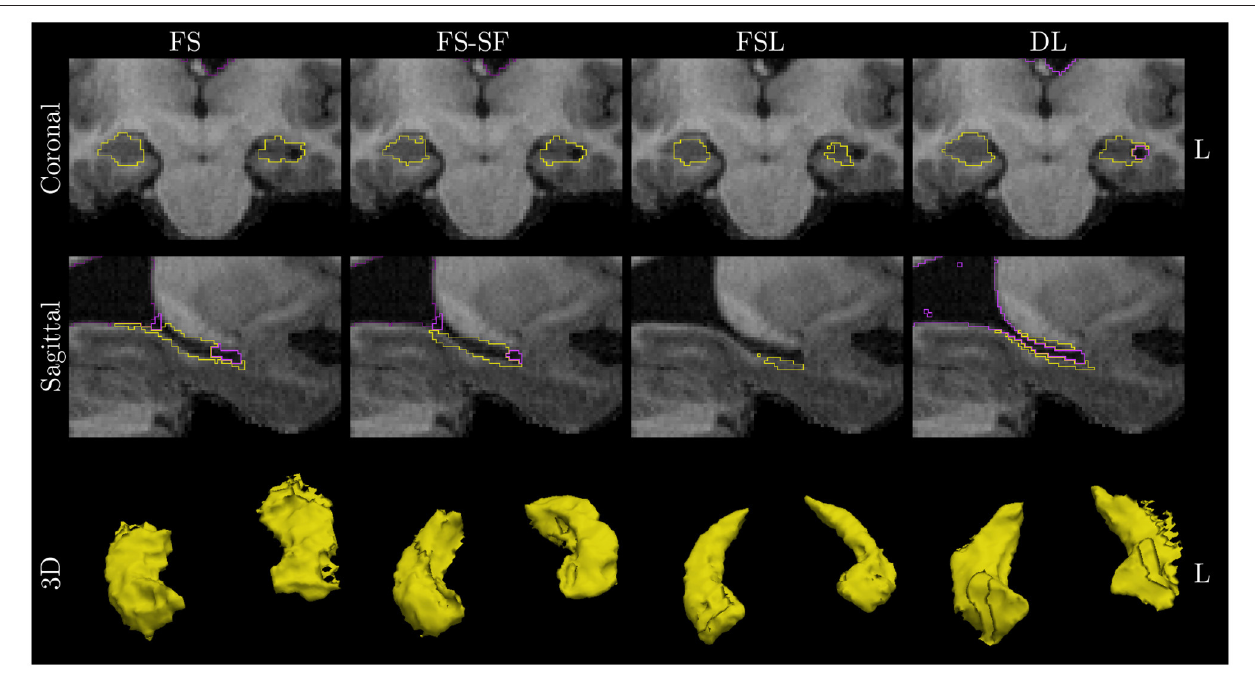
FIGURE 3 | Qualitative example of a case with left HS. Images are in radiological orientation, i.e., the left (L) hemisphere appears on the right side of the image. Boundaries of the segmentation are outlined for the hippocampi (yellow) and ventricles/CSF (purple). Coronal view of the hippocampal body and sagittally of the left hippocampus. While FS correctly identified fluid-filled cavities at the tail and head of the hippocampus, this was only fully captured by deep learning (DL) along the entire body of the hippocampus. The example corresponds to the case highlighted in Figure 1